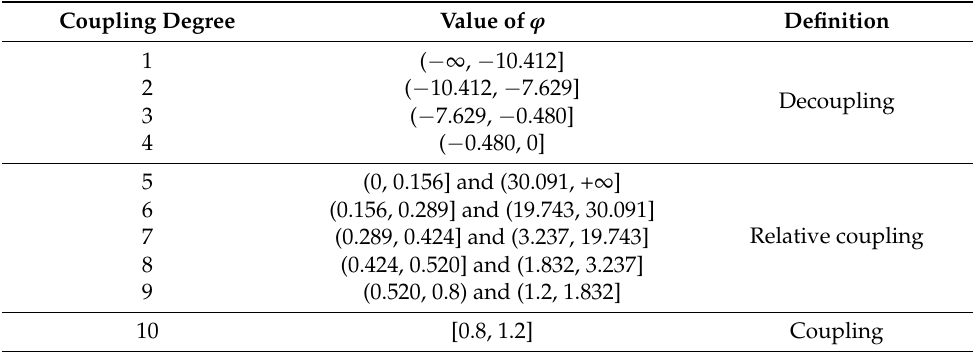
Table 2. Classification rank of decoupling coefficient.